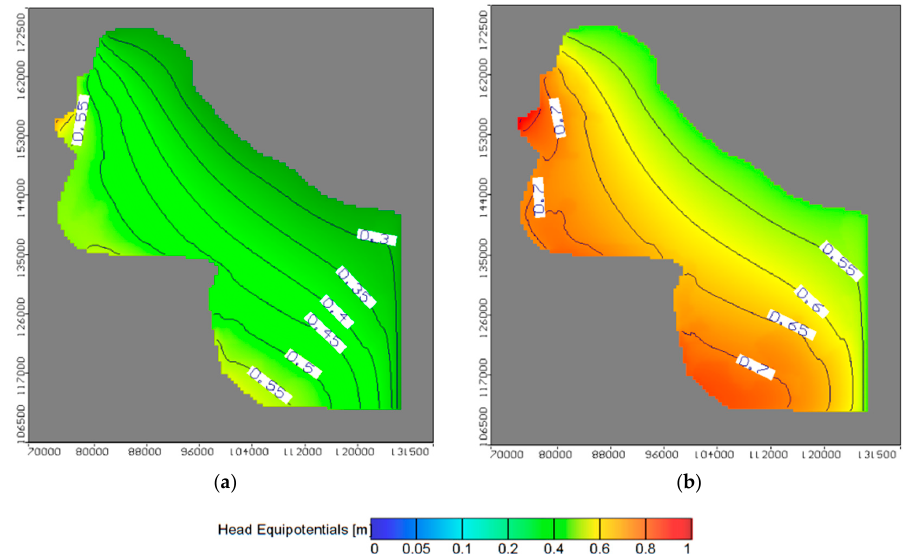
Figure 9. Arial view of groundwater level in study area at sea level rise (SLR) by ( a ) 26.70 and ( b ) 51.30